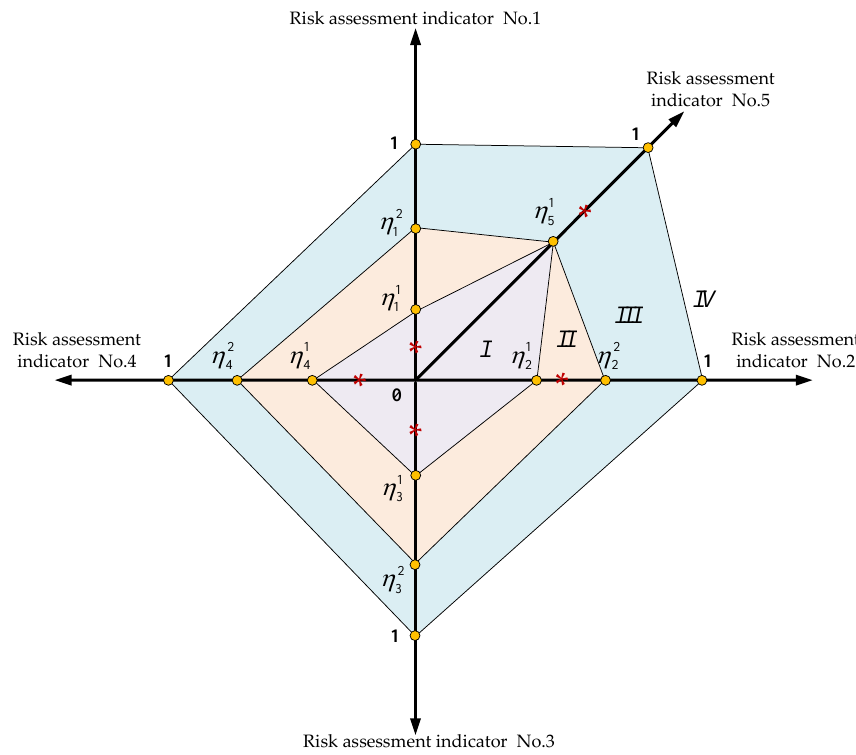
Figure 7. Multi-dimensional risk assessment space.